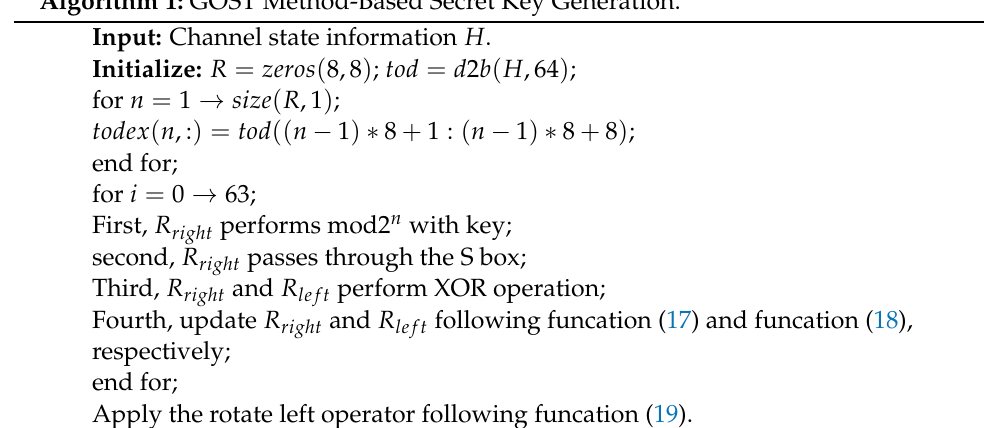
Algorithm 1: GOST Method-Based Secret Key Generation.